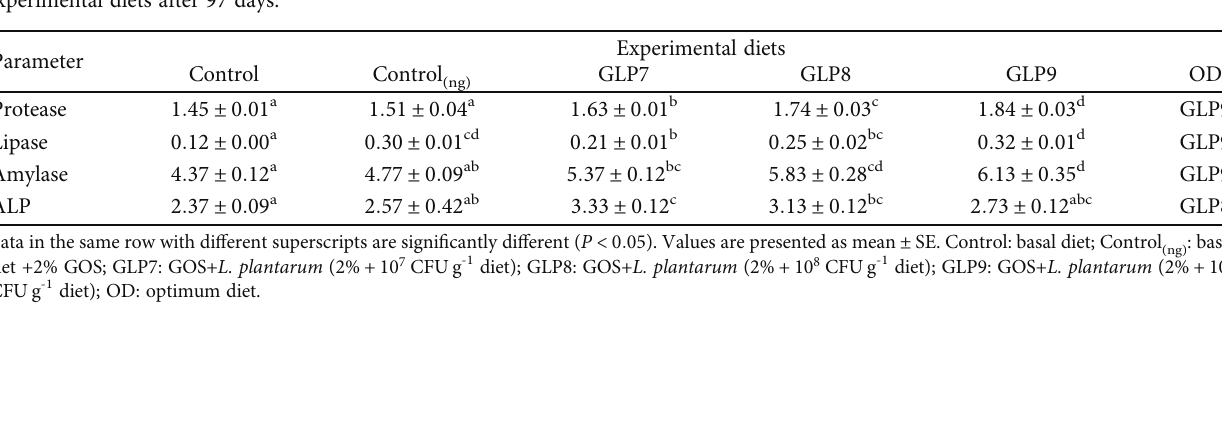
Experimental diets